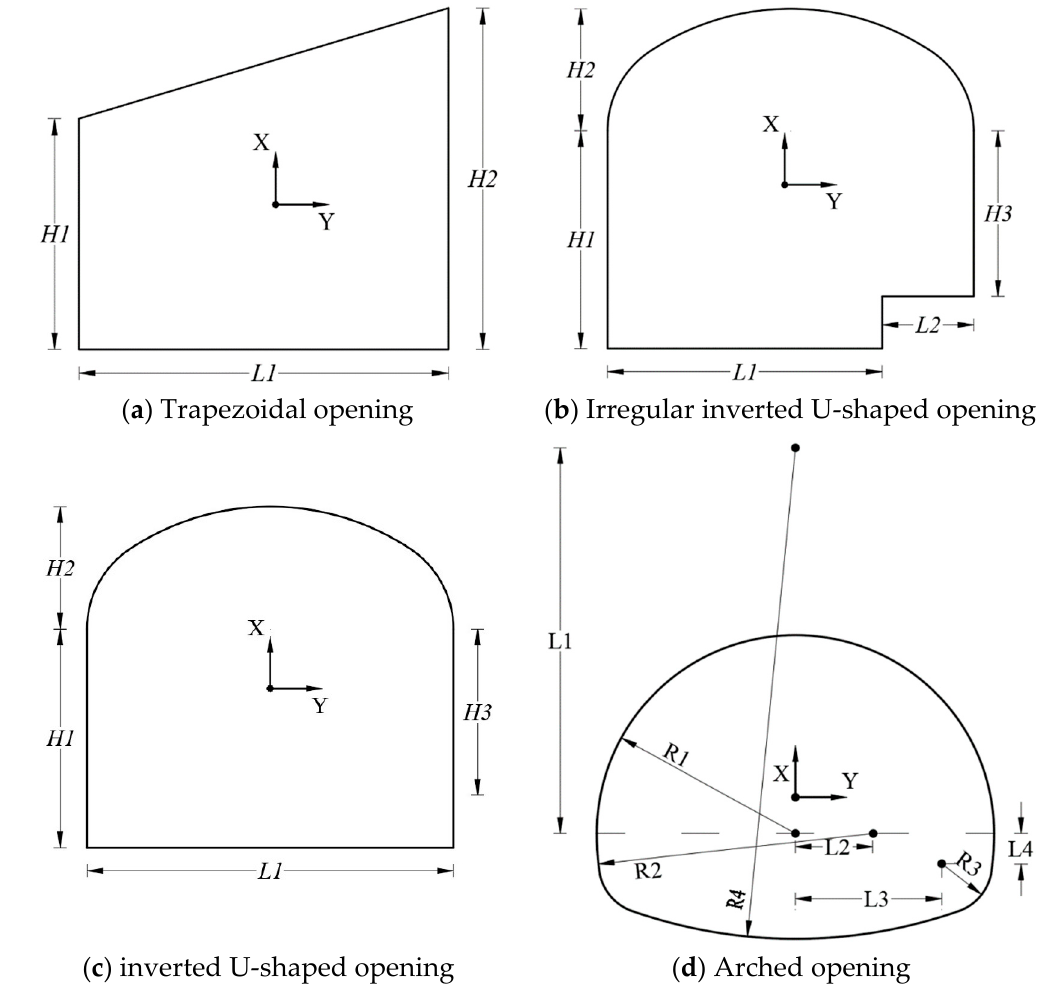
Figure 3. Four openings with typical shapes